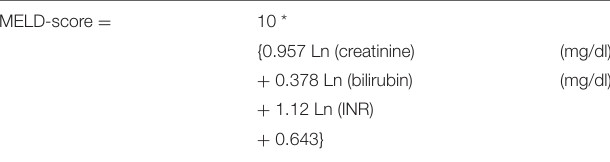
TABLE 7 | Model of end-stage liver disease MELD.